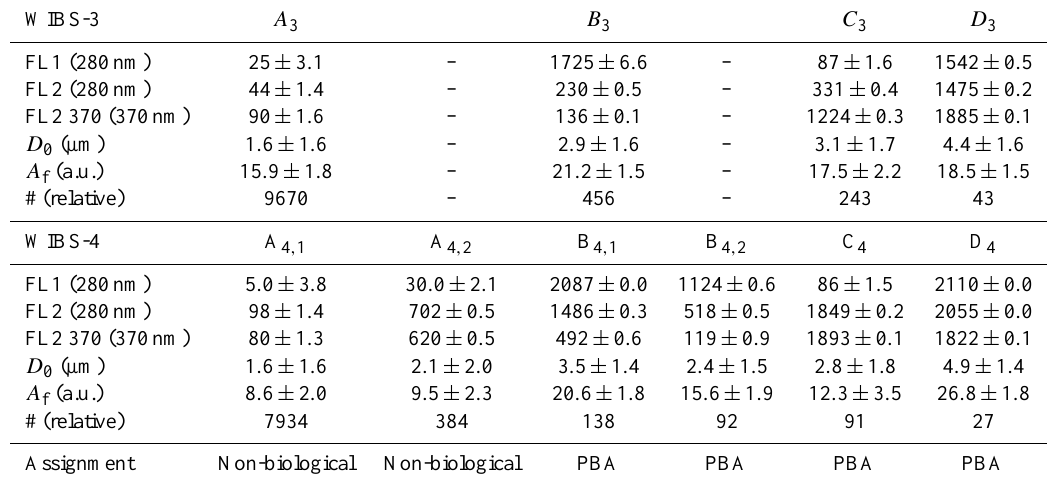
Table 1. WIBS-3 cluster solutions, A 3 − D 3 , WIBS-4 cluster solutions, A 4 − D 4 , showing typical average UV FL1-3 channel intensities, average optical diameter, D o (µm), asymmetry factor, A f , and associated standard deviations within each